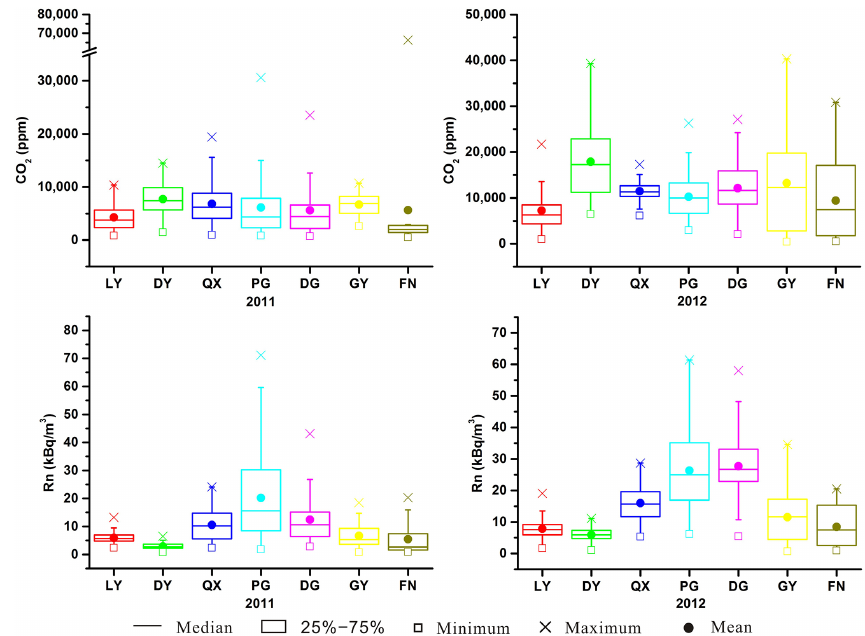
Figure 3. Box plots of Rn and CO 2 over the two surveys in the capital area of